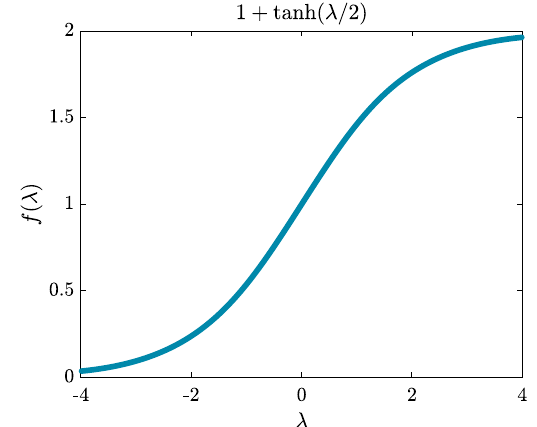
FIG. 5. A plot of f ð λ Þ ¼ 1 þ tanh ð λ = 2 Þ to illustrate its bound- edness and positivity.